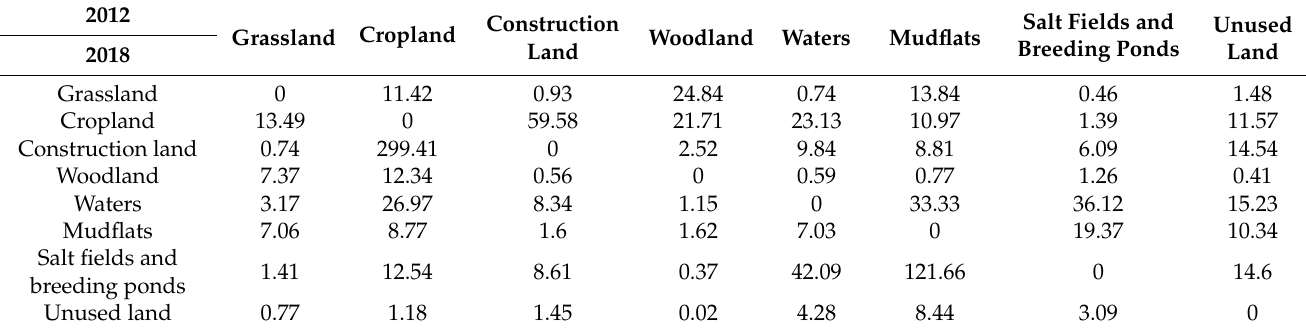
Table 4. The Yellow River Delta landscape type transfer matrix for 2012–2018.